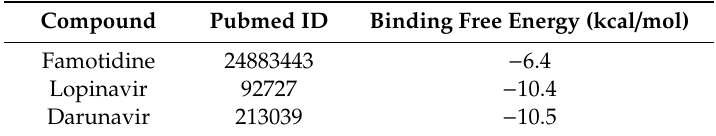
Table 5. Binding free energies calculated for famotidine and other protease inhibitors upon docking to HIV